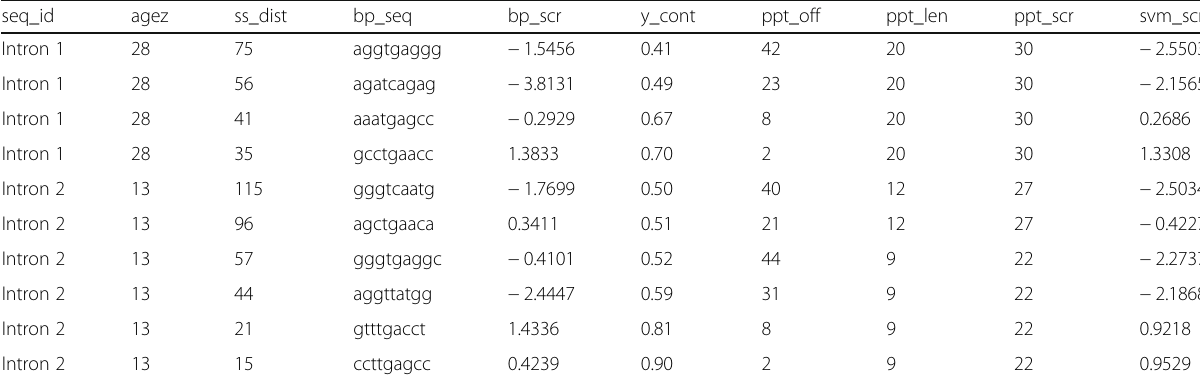
Table 3 The potential predicted branch point (BP) and polypyrimidine tract (ppt) in buffalo CATH4 unspliced cDNA